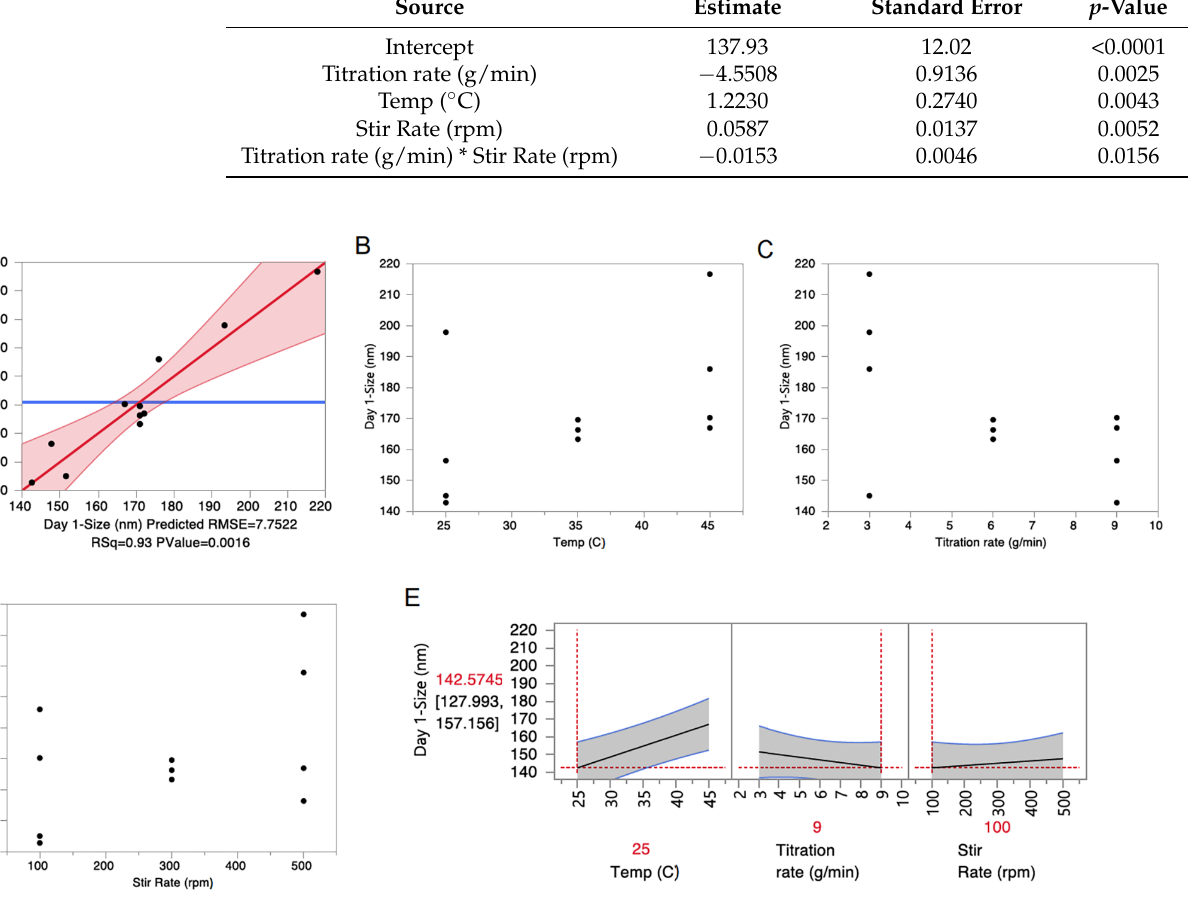
Figure 6. ( A ) Actual vs. predicted plot demonstrates that the multiple linear regression (MLR) model predicts the nanoemulsion diameter as a function of nanoemulsion processing parameters with an R 2 value of 0.93. ( B – D ) Plots of nanoemulsion diameter vs. temperature (Panel B), water titration rate (Panel C), and stir rate (Panel D) suggest that nanoemulsion diameter decreases with increasing water titration rate, decreasing temperature, and decreasing stir rate. ( E ) The MLR prediction profiler confirms these findings.